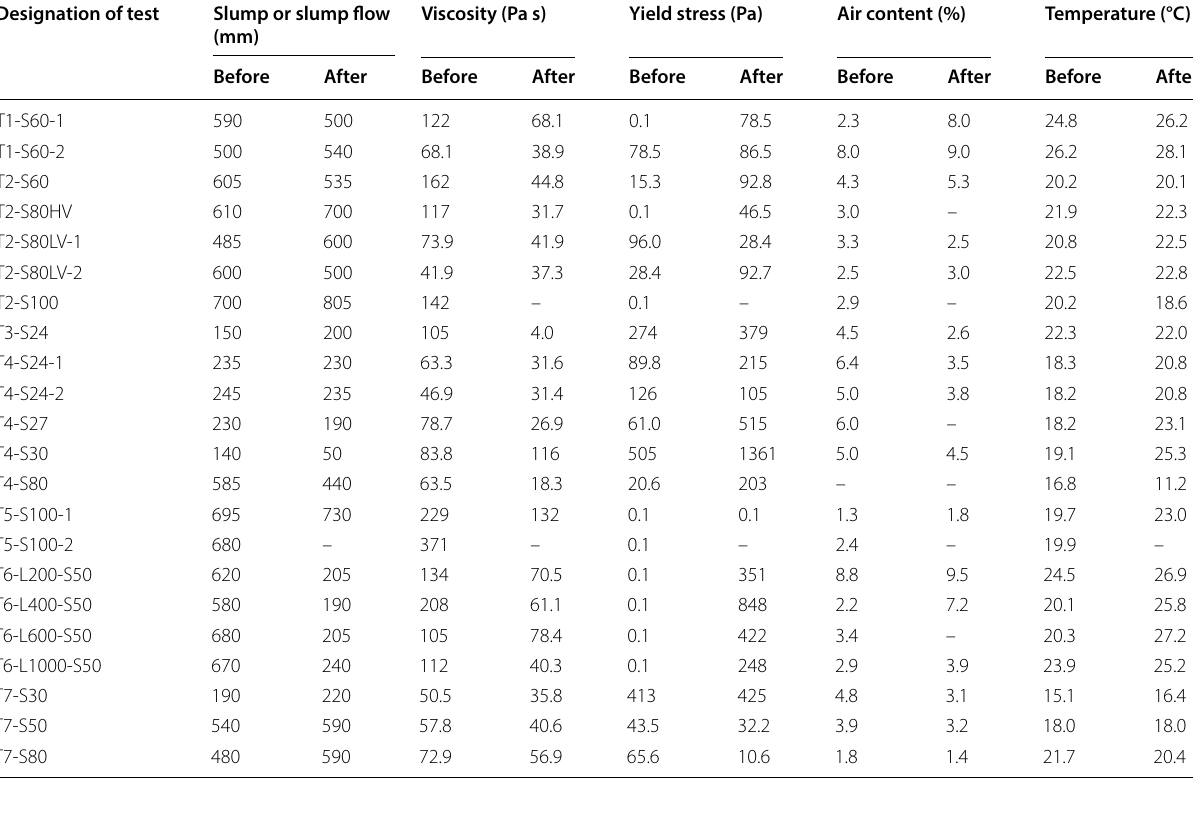
Table 3 Measurements before and after pumping in the real-scale pumping tests.